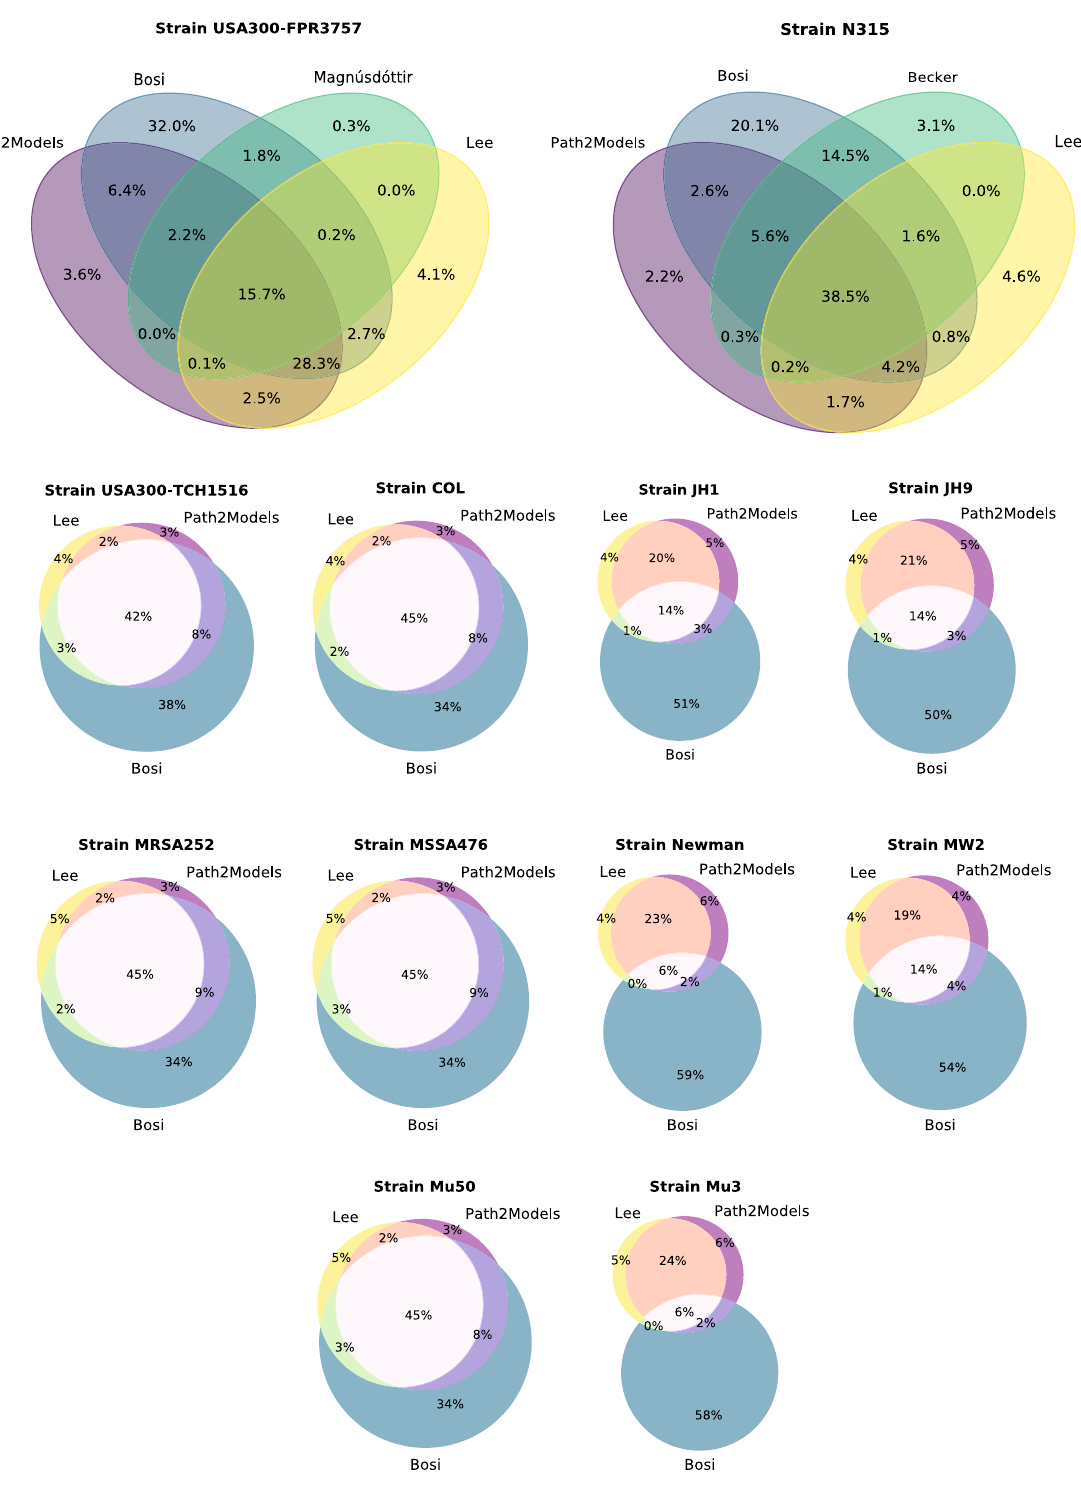
Fig. 6 Strain-speci fi c model comparison based on gene sets. For all models occurring in at least three different resources, the gene content was compared strain-speci fi cally. After unifying the gene identi fi ers to KEGG IDs, Venn diagrams were created comparing the gene content. The models from Bosi et al. have, on average, the highest gene content, explaining the large fraction of genes occurring only in these models. The models by Lee et al. and the Path2Models project seem more similar, which could be explained by the fact that both are curated based on the KEGG database. Although all models in one Venn diagram (and thus, one comparison) represent the same strain, the models have differences, indicating the in fl uence of the reconstruction method on the fi nal model content.